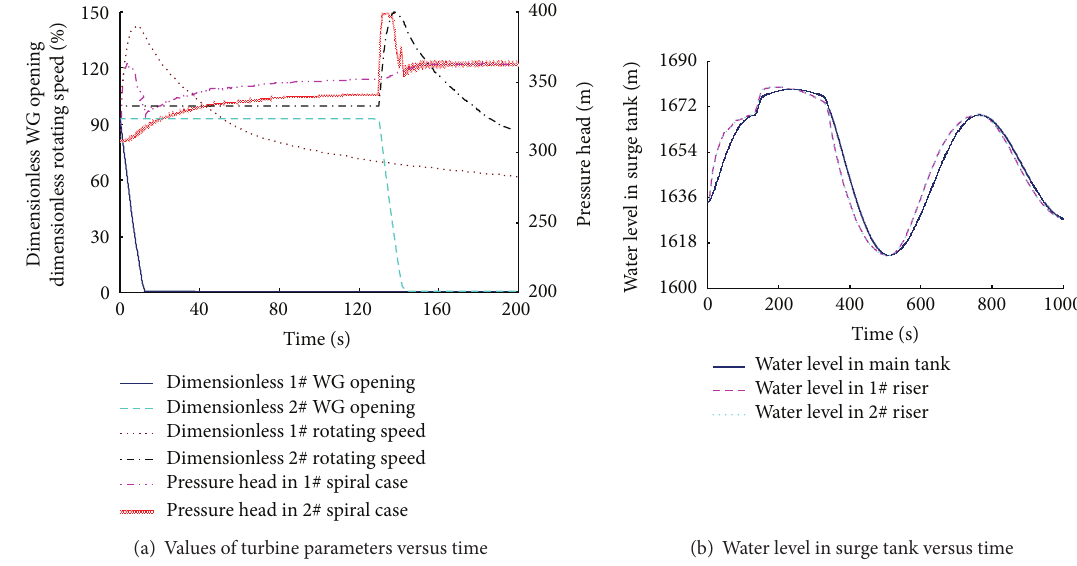
Figure 5: Numerical results of successive load rejection.